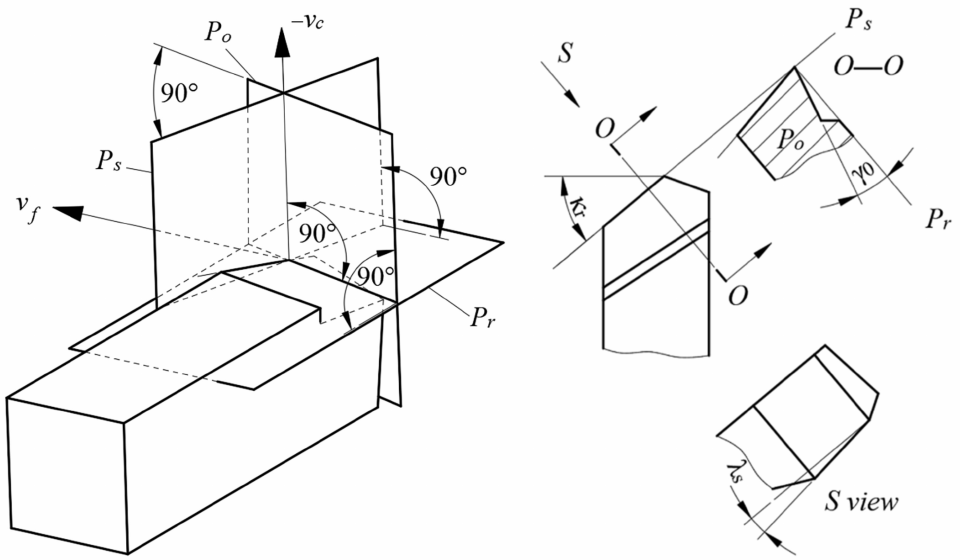
Figure 10. The orthogonal plane coordinate system and the tool parameters